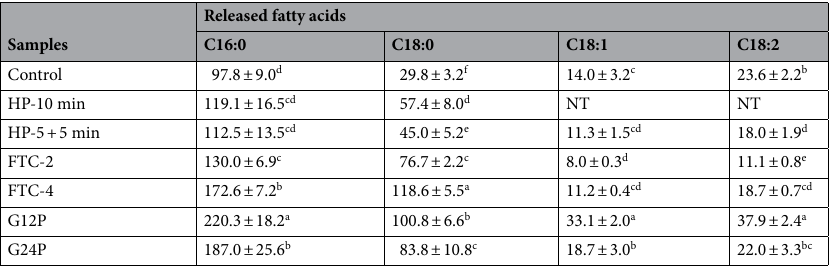
Table 1. Main released fatty acids (μg/g) of brown rice processed with different treatments after in vitro digestion. Values are means ± standard deviations (n = 3). Within columns, means followed by different letters are significantly different ( p < 0.05). NT: not